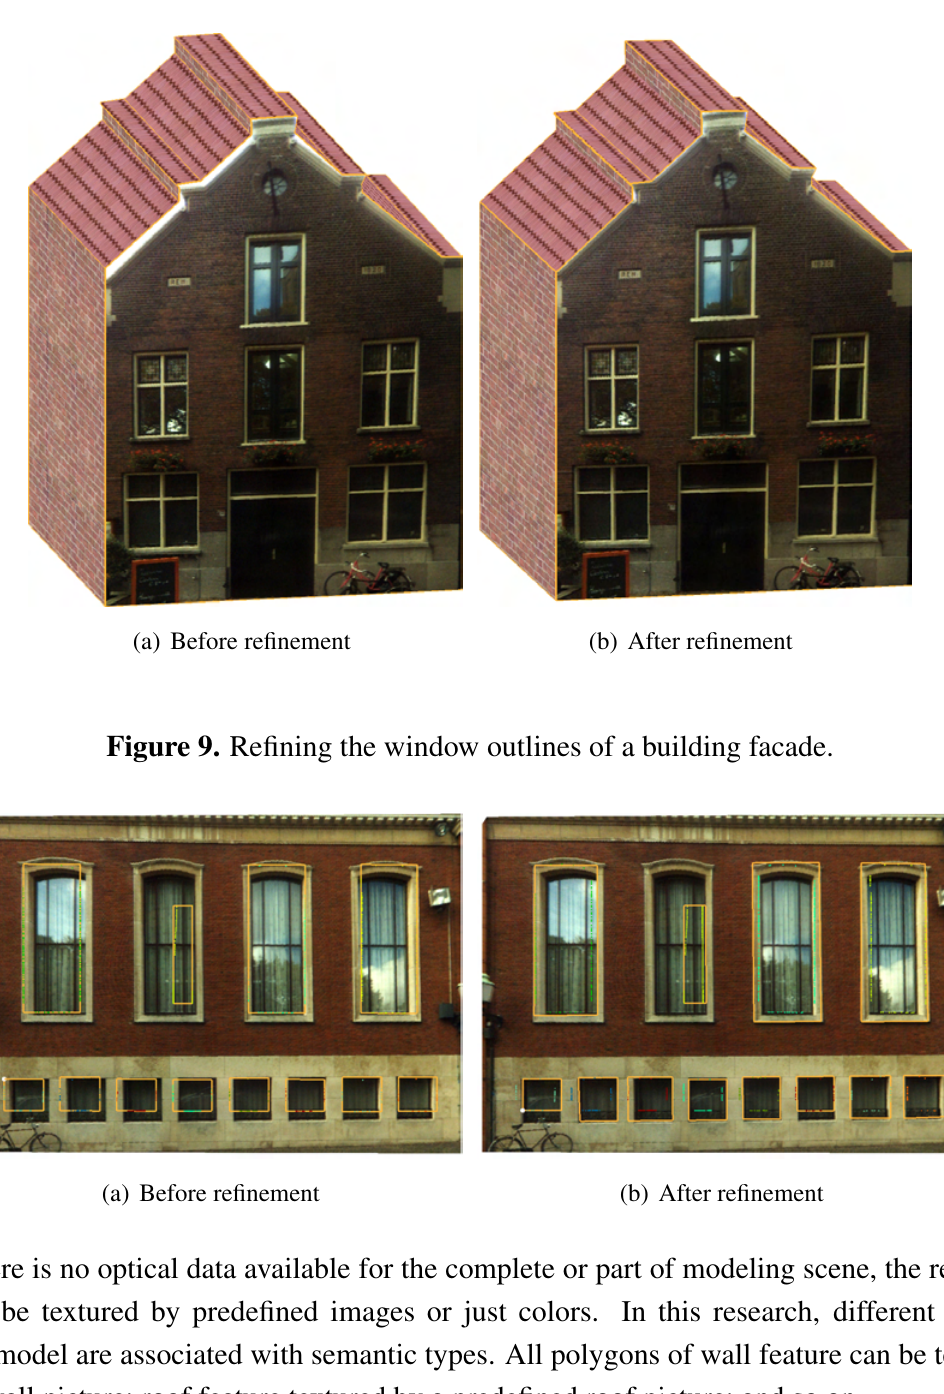
Figure 8. Refining the wall outlines of a building facade.